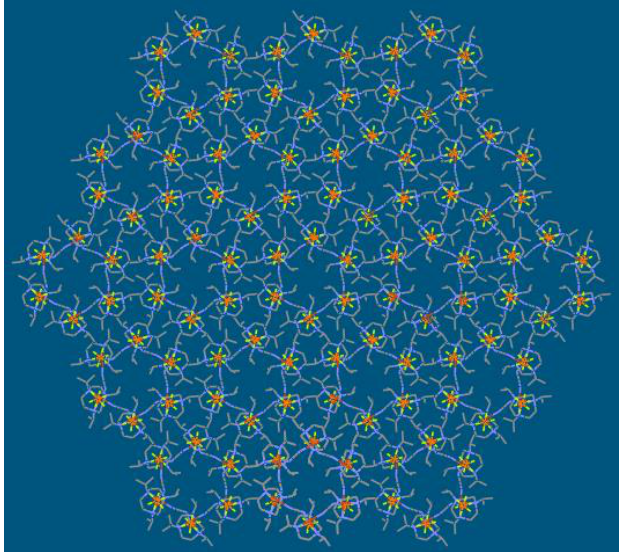
Figure 2. Stacking diagram of 1 along the c axis showing the regular array of hexahydric rings and the PF 6− anions.